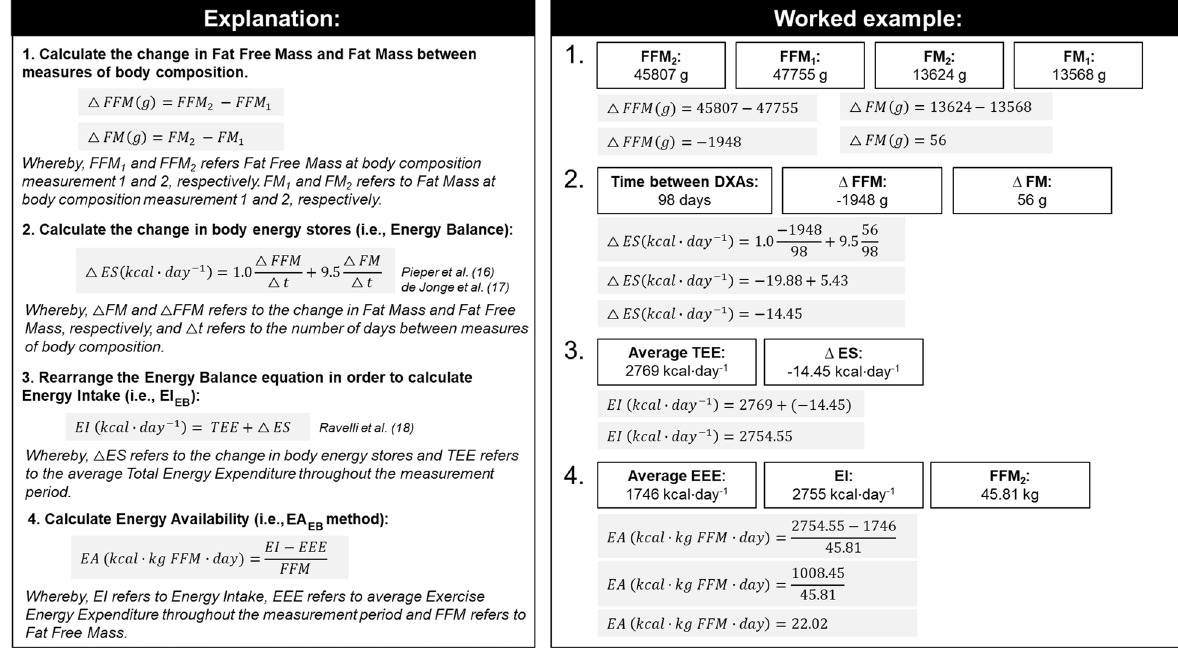
Fig. 1 Calculating EA using the EA EB